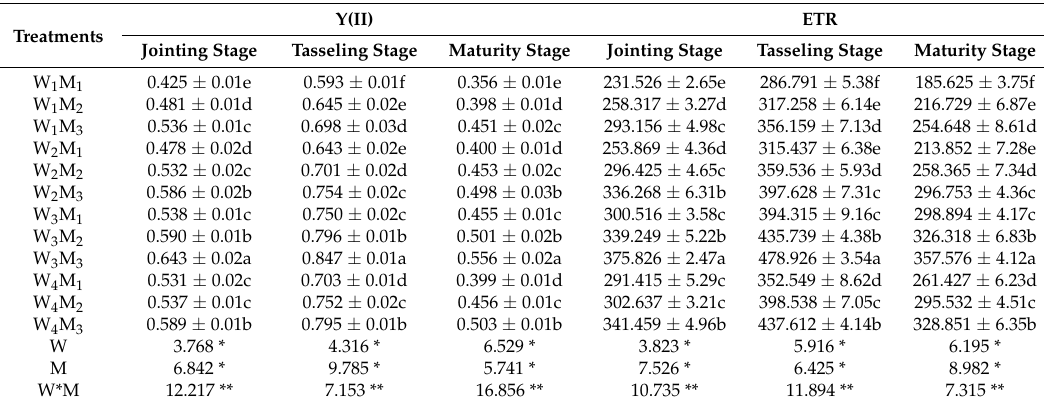
Table 6. Effect of irrigation amount on degradable film covering drip-irrigated maize Y(II) and ETR. Y(II) ETR Treatments Jointing Stage Tasseling Stage Maturity Stage Jointing Stage Tasseling